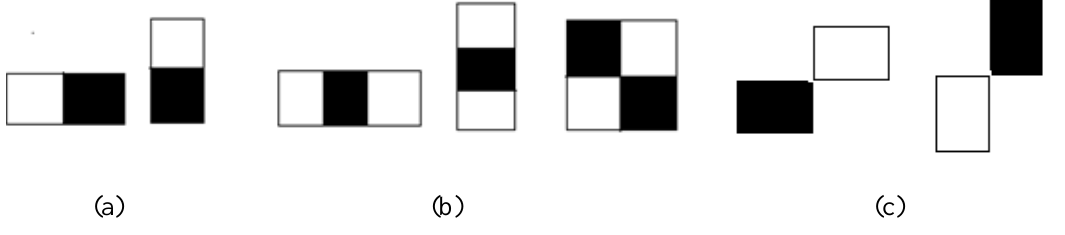
Figure 1. Examples of the Haar-like feature set. ( a ) Basic feature set which consists of two adjacent rectangles. ( b ) and ( c ) Extended feature sets which consist of different number and arrangement of rectangles,